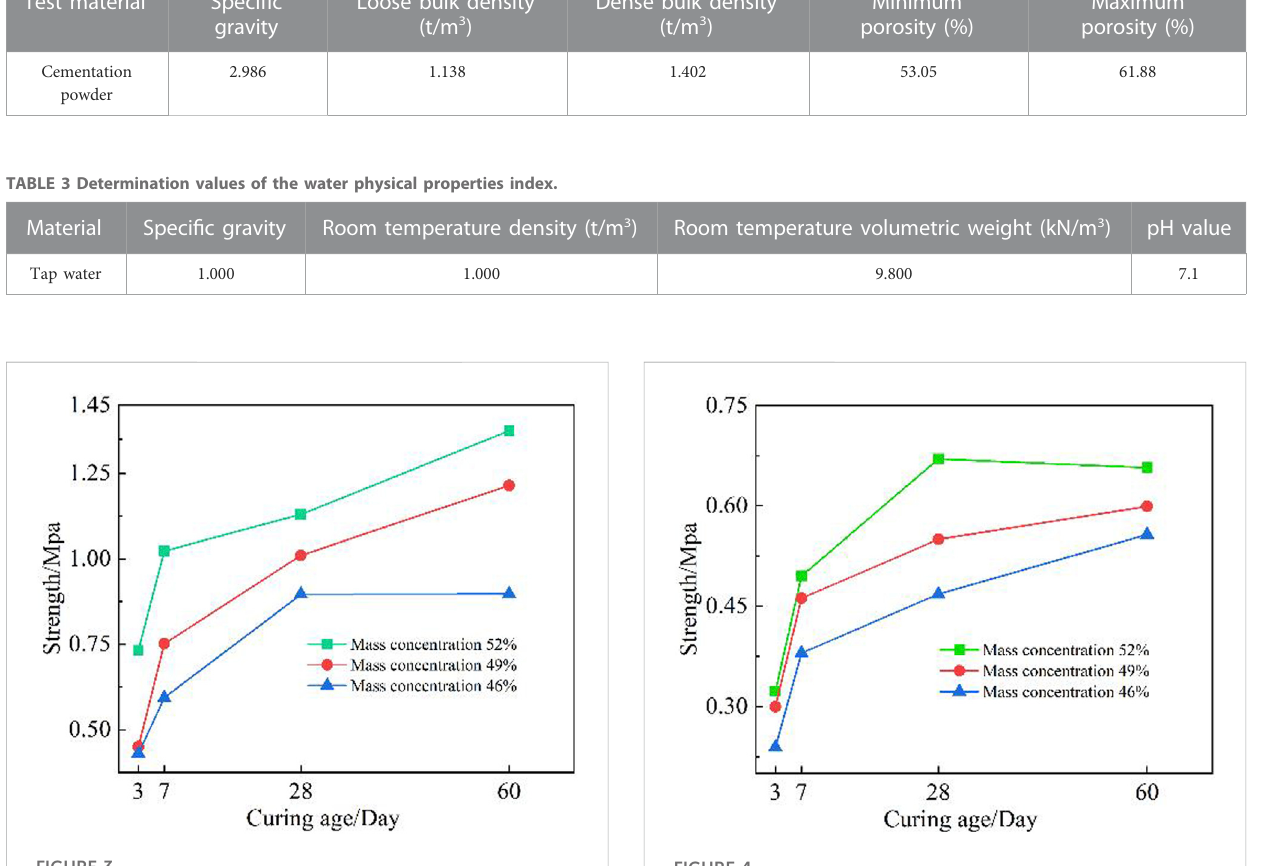
FIGURE 4 Variation of the strength of back fi ll materials with age for ash- tailings ratio 1:9.